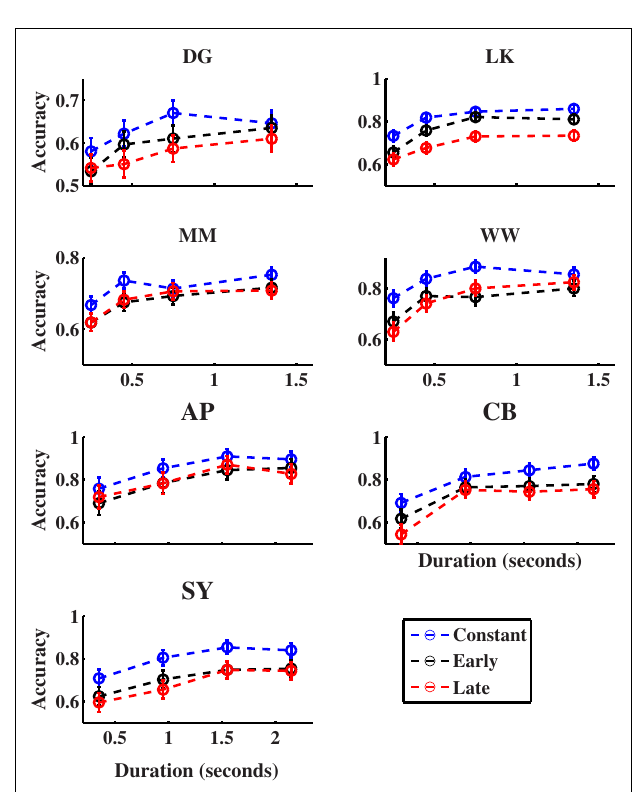
FIGUREA3 |Accuracy as a function of stimulus duration and condition in Experiment 2A (participants DG, LK, MM, andWW) and Experiment 2B (adaptive condition; participantsAP, CB, and SY). Error bars correspond to 95%